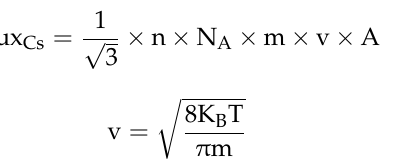
In Equation (3), K B is the Boltzmann constant, and T is temperature (K). The total Cs flux has a strong increase between 200 ◦ C and 260 ◦ C, which can be seen in Figure 12. The calculation results meet the design